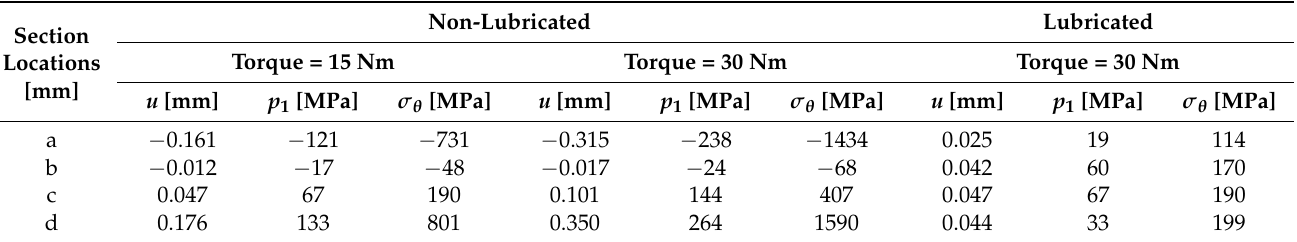
Table 3. Displacement, internal pressure, and hoop stress of inner ring, for Test 1b.